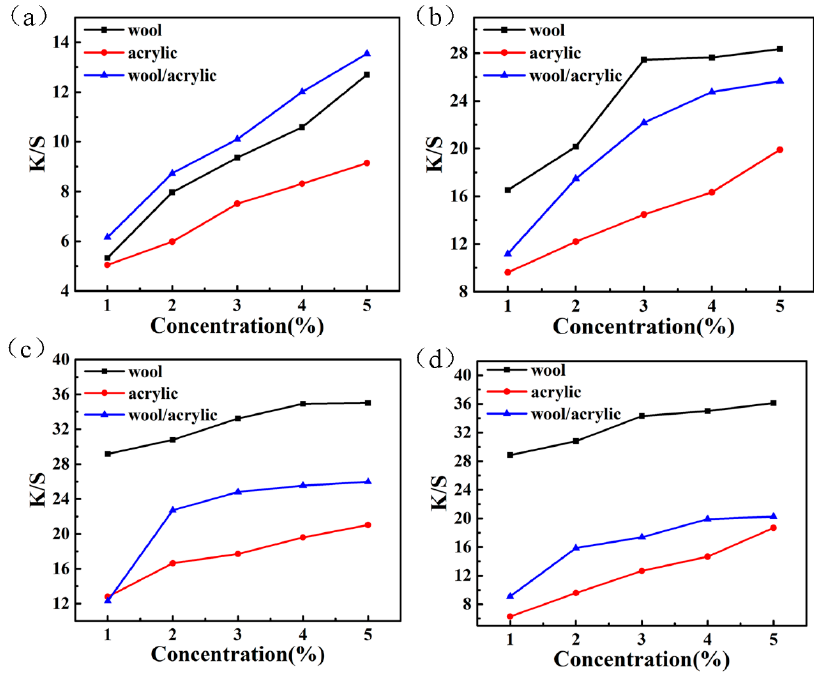
Figure 11. Build-up property of the heterocyclic reactive dyes. ( a ) Dye 1; ( b ) Dye 2; ( c ) Dye 3; ( d ) Dye 4.